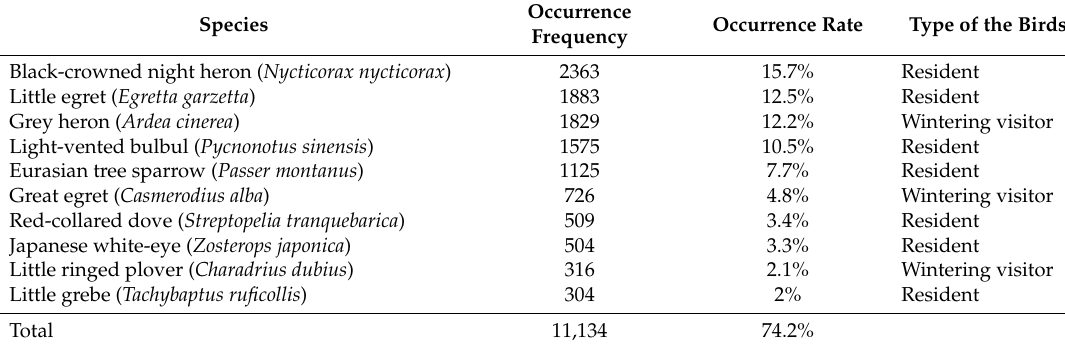
Table 2. Identification of nine generalist species, which were greater in number than other species and accounted for 74% of all species abundance (only little grebe, Tachybaptus ruficollis , is not a generalist